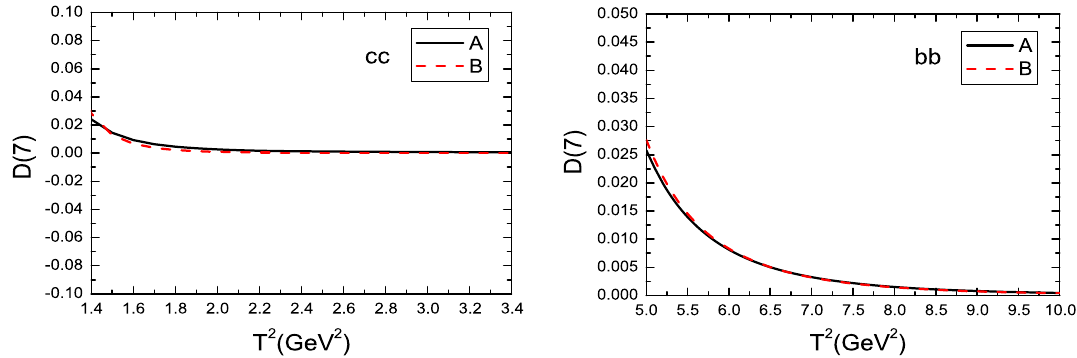
Fig. 2 The contributions of the vacuum condensates of dimension 7 in the operator product expansion, where A and B denote the (cid:10) QQ baryon states with J = 1 and 3 , respectively 2 2